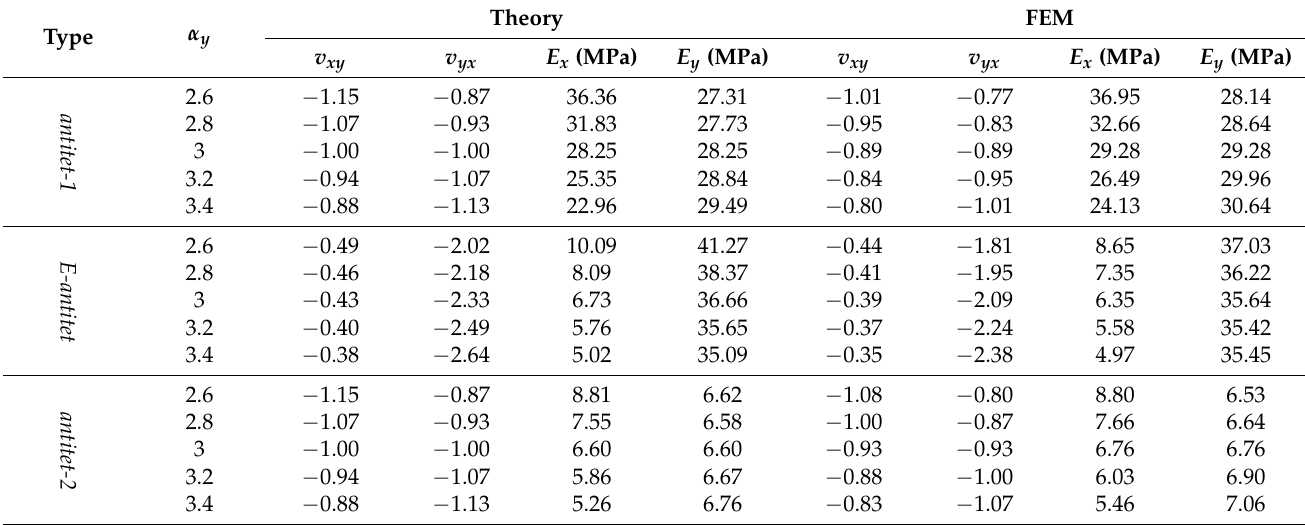
Table A4. Detailed results of Poisson’s ratio and Young’s modulus of E-antitet at different α y .